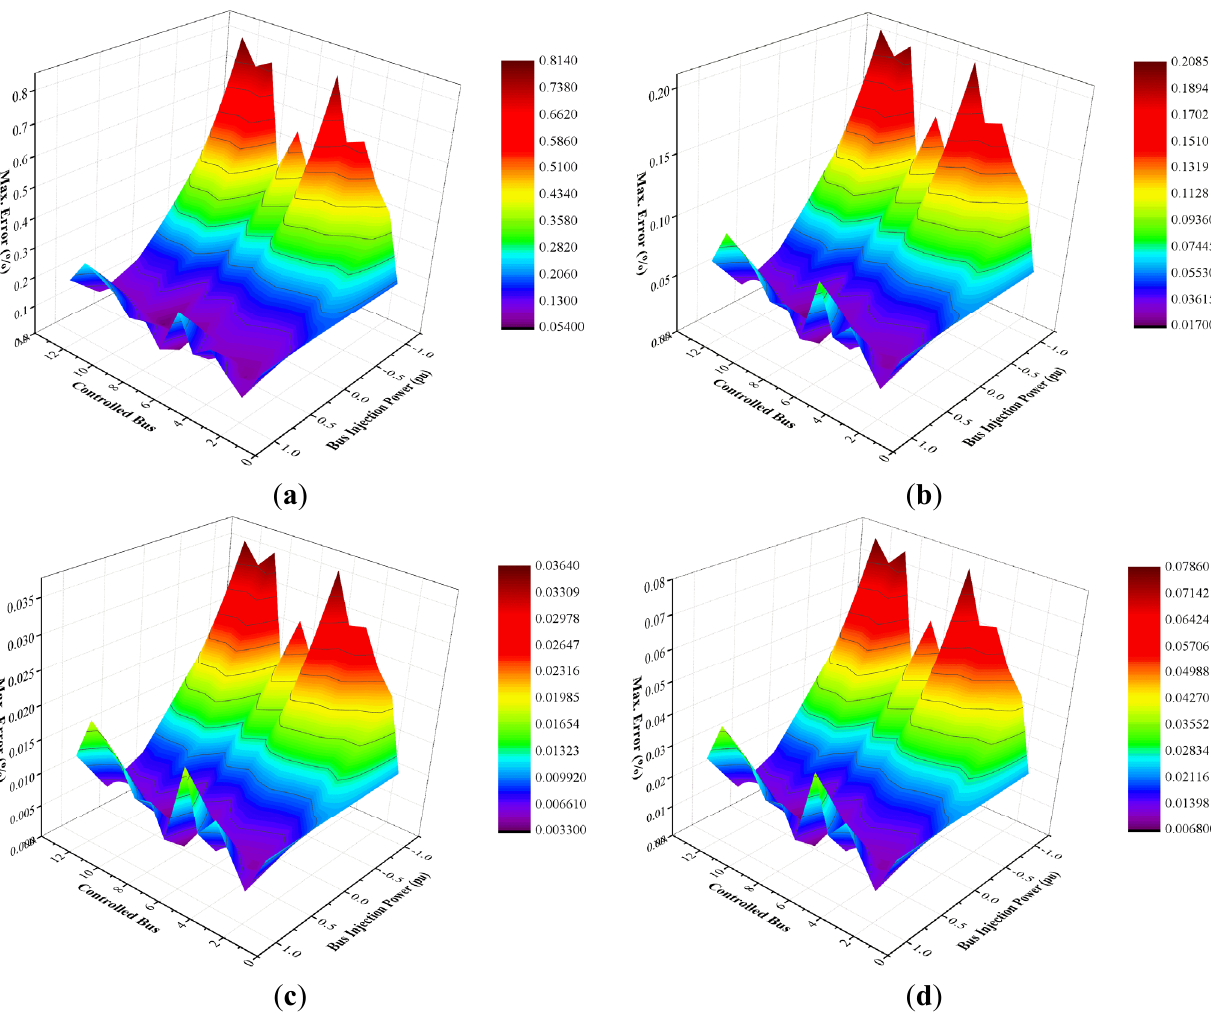
Figure 3. The maximum error of the approximate expression for voltage sensitivity as a function of the injected power at the bus. ( a ) V slack = 0.6 pu; ( b ) V slack = 0.8 pu; ( c ) V slack = 1.0 pu; ( d ) V slack = 1.2